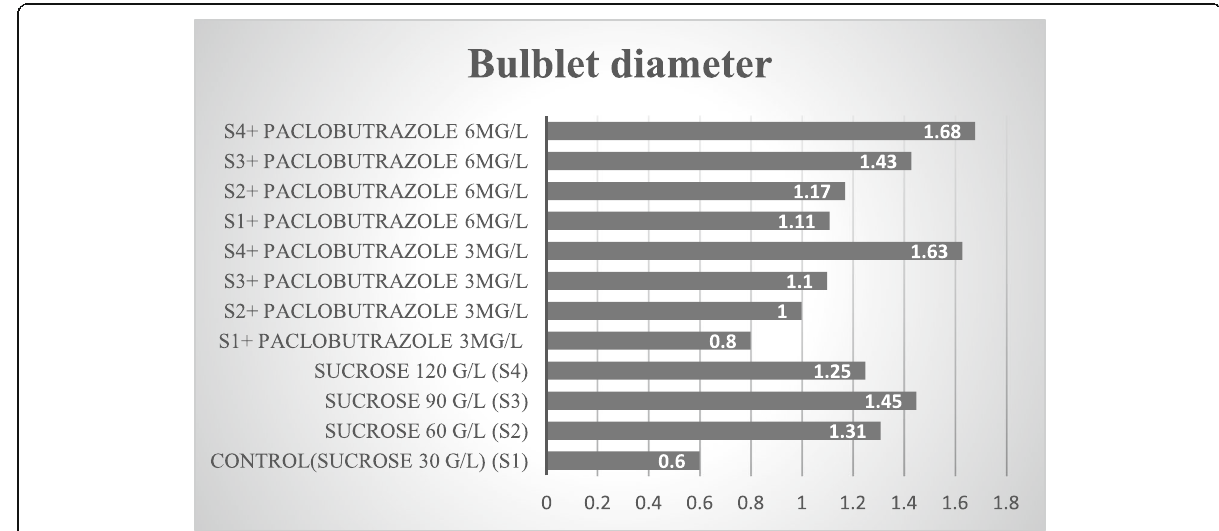
Fig. 5 Bulblets ’ diameter of oriental hybrid lily as effected by different concentrations of sucrose and paclobutrazol